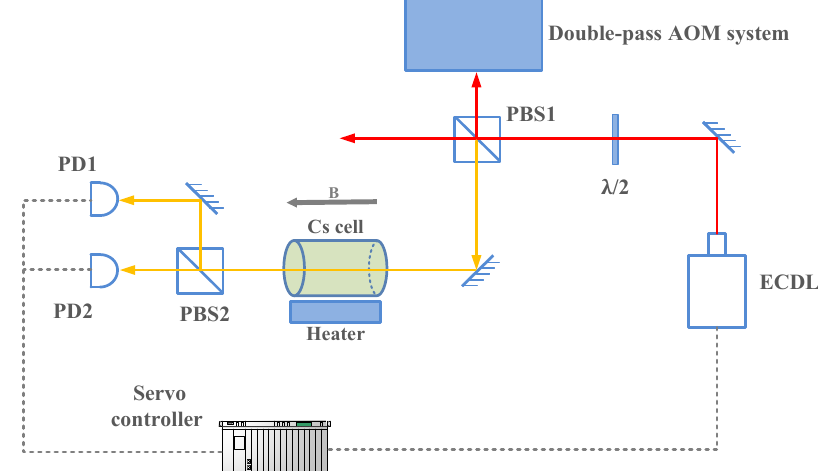
Figure 6. Experimental setup. PBS: polarizing beam splitter; λ /2: half wave plate; PD: photo detector; Double-pass AOM system: a system consists of acousto–optic modulator, quarter wave plate, plano-convex mirror and reflector; ECDL: an external cavity diode laser at 852 nm. (Figure reproduced from [53].)